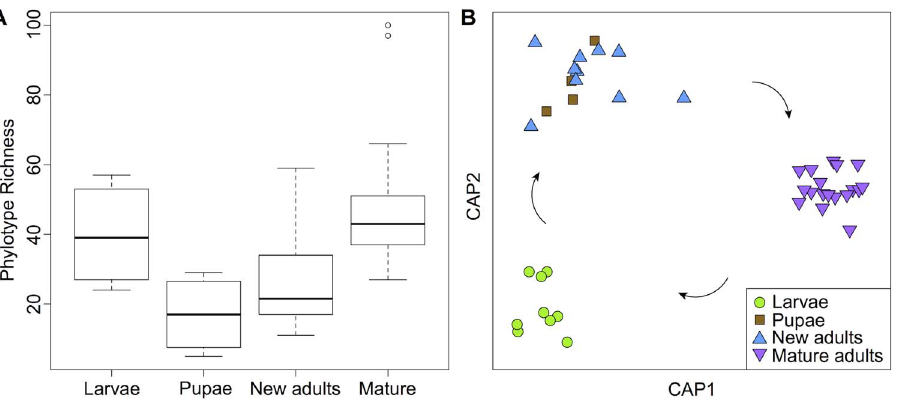
Figure 1. Bacterial community dynamics across H.erato larvae, pupae, newly emerged adults, and mature adults. A. Boxplot of community phylotype richness. B. Constrained principal coordinates analysis showing variation in community composition over the life cycle. CAP1 and CAP2 are the canonical axes in principal coordinate space that best discriminate among life stages. Arrows indicate significant pairwise differences in composition.